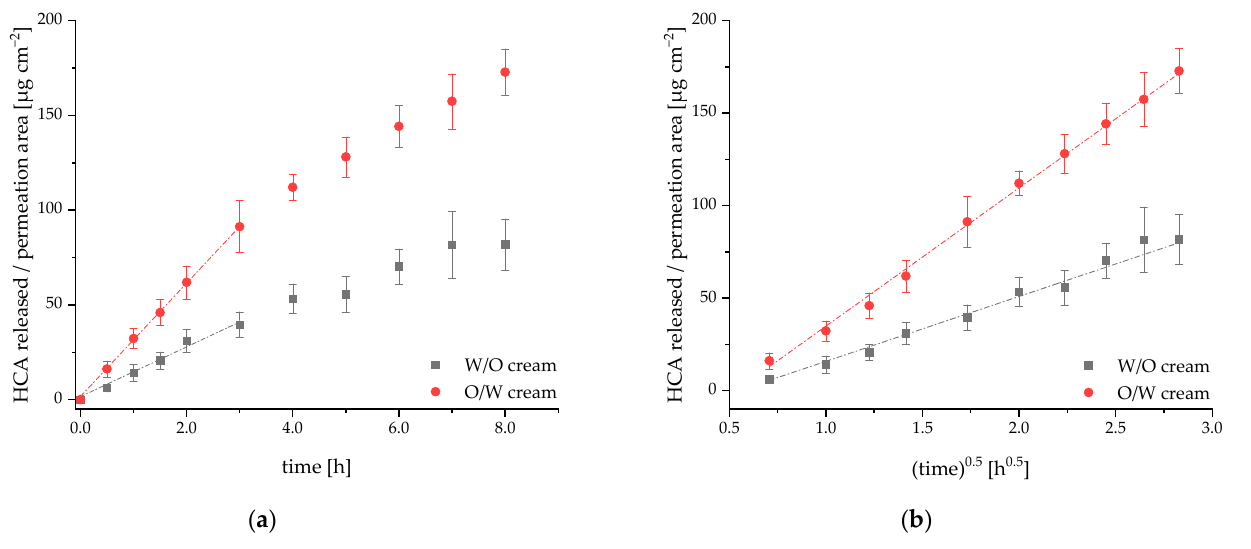
Figure 6. Release profile of HCA from the O/W cream (red dots) and W/O cream (black squares). Profiles were obtained using Franz diffusion cells with polyether sulfone membranes (not rate-limiting) to separate donor cream from acceptor medium (30% ethanol). ( a ) The initial flux of HCA (J ini ) was determined from the first 3 h of HCA release. ( b ) The amount of released HCA is proportional to the square root of time, i.e., it follows the Higuchi model for drug release from non-erodible matrix systems. Bars indicate standard errors from n = 3 independent experiments.